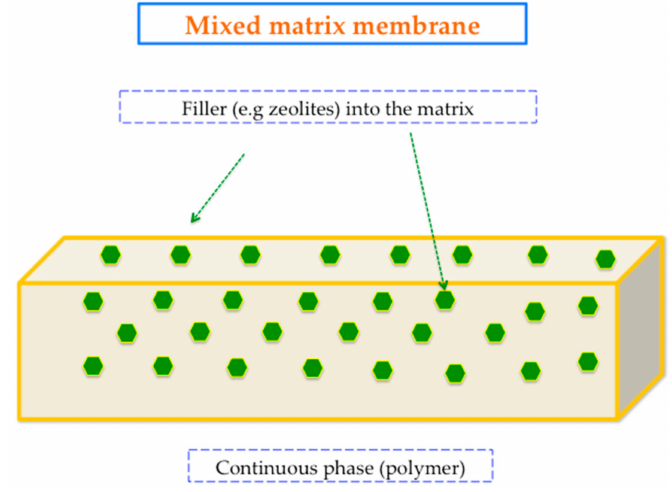
Figure 5. Mixed matrix membrane